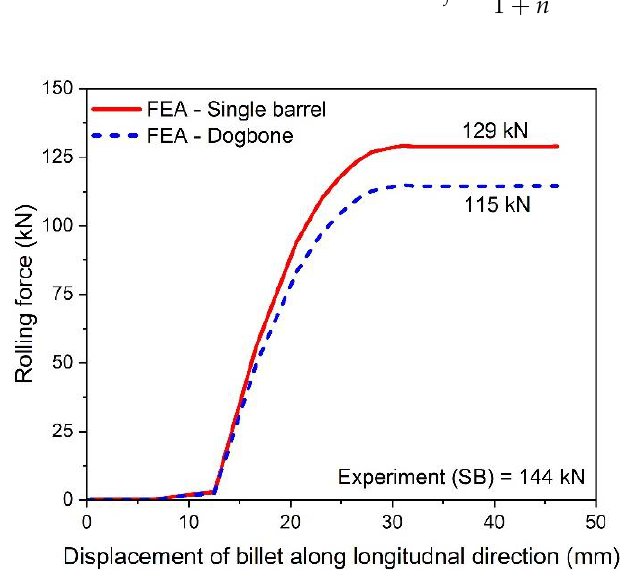
Figure 13. Variation of rolling force with billet displacement for a single and double barrel.